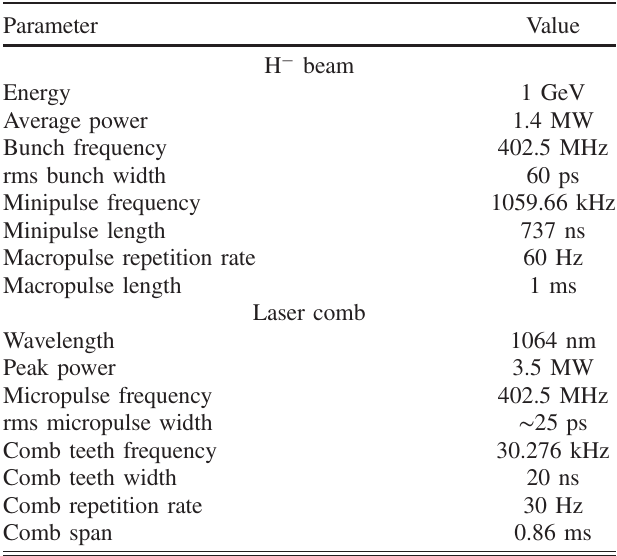
TABLE I. Parameters of the H − beam at the emittance measurement station and typical laser comb setting used in the experiments. Some laser comb parameters are adjusted for certain